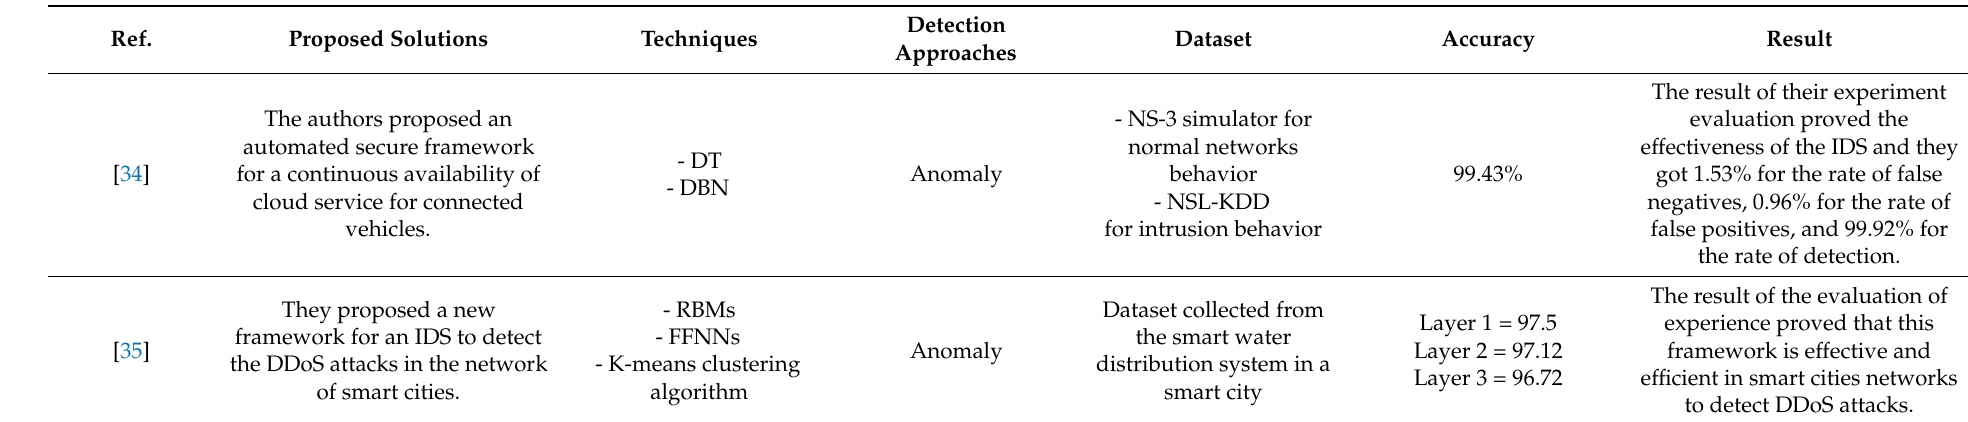
Table 2. IDS in IoT-based smart